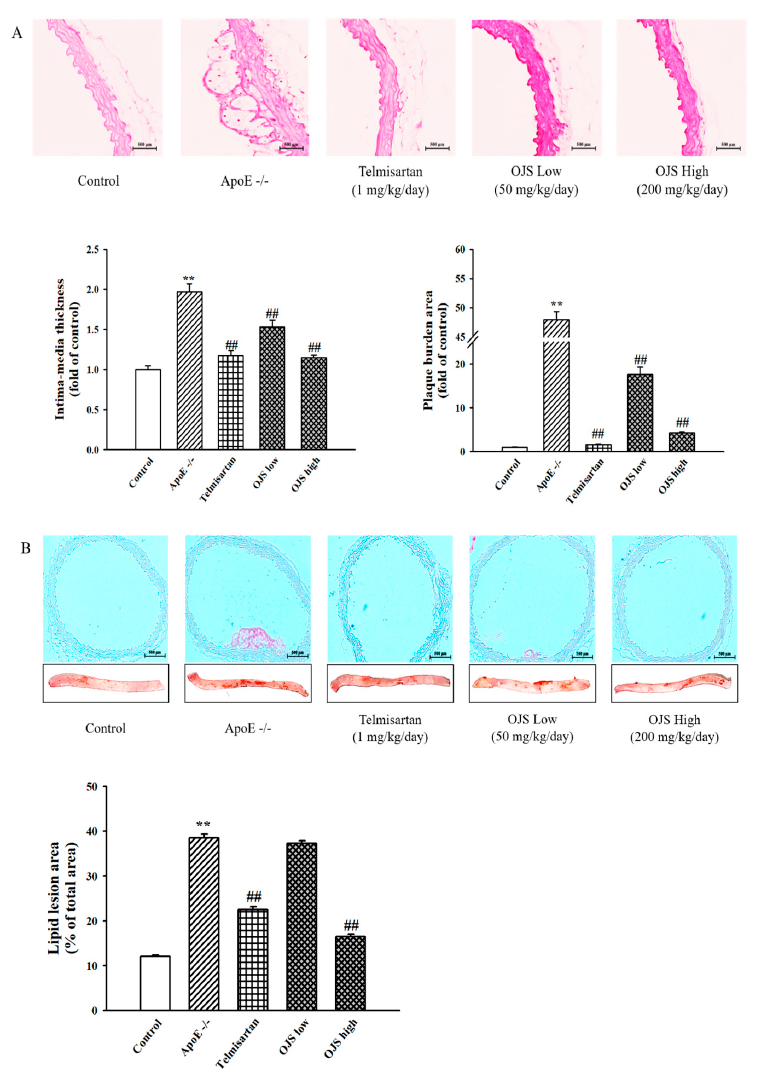
Figure 3. Effect of OJS on atherosclerotic lesion in ApoE − / − mice. Microscopic photographs of the aorta stained with hematoxylin and eosin (H&E) ( A ). Lipid lesion area staining in the aorta (100×). Thoracic and abdominal aorta from the indicated genotype were cut open with the luminal surface facing upward, and the inner aortic surface was stained with Oil Red O ( B ). Data are presented as means ± S.E. ** p < 0.01 vs. control group; ## p < 0.01 vs. ApoE − / − group.